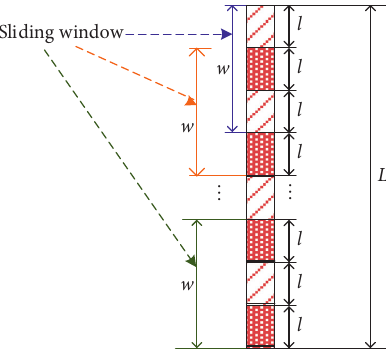
Figure 2: Schematic diagram of sliding